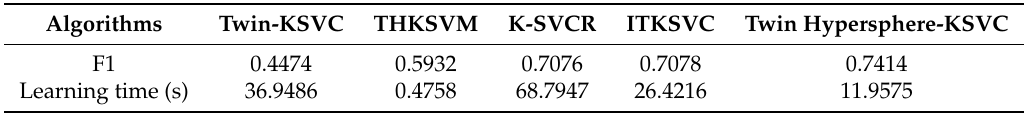
Table 8. Classification results of Twin Hypersphere-KSVC, Twin-KSVC, THKSVM, K-SVCR and ITKSVC for text classification on the Reuters21578